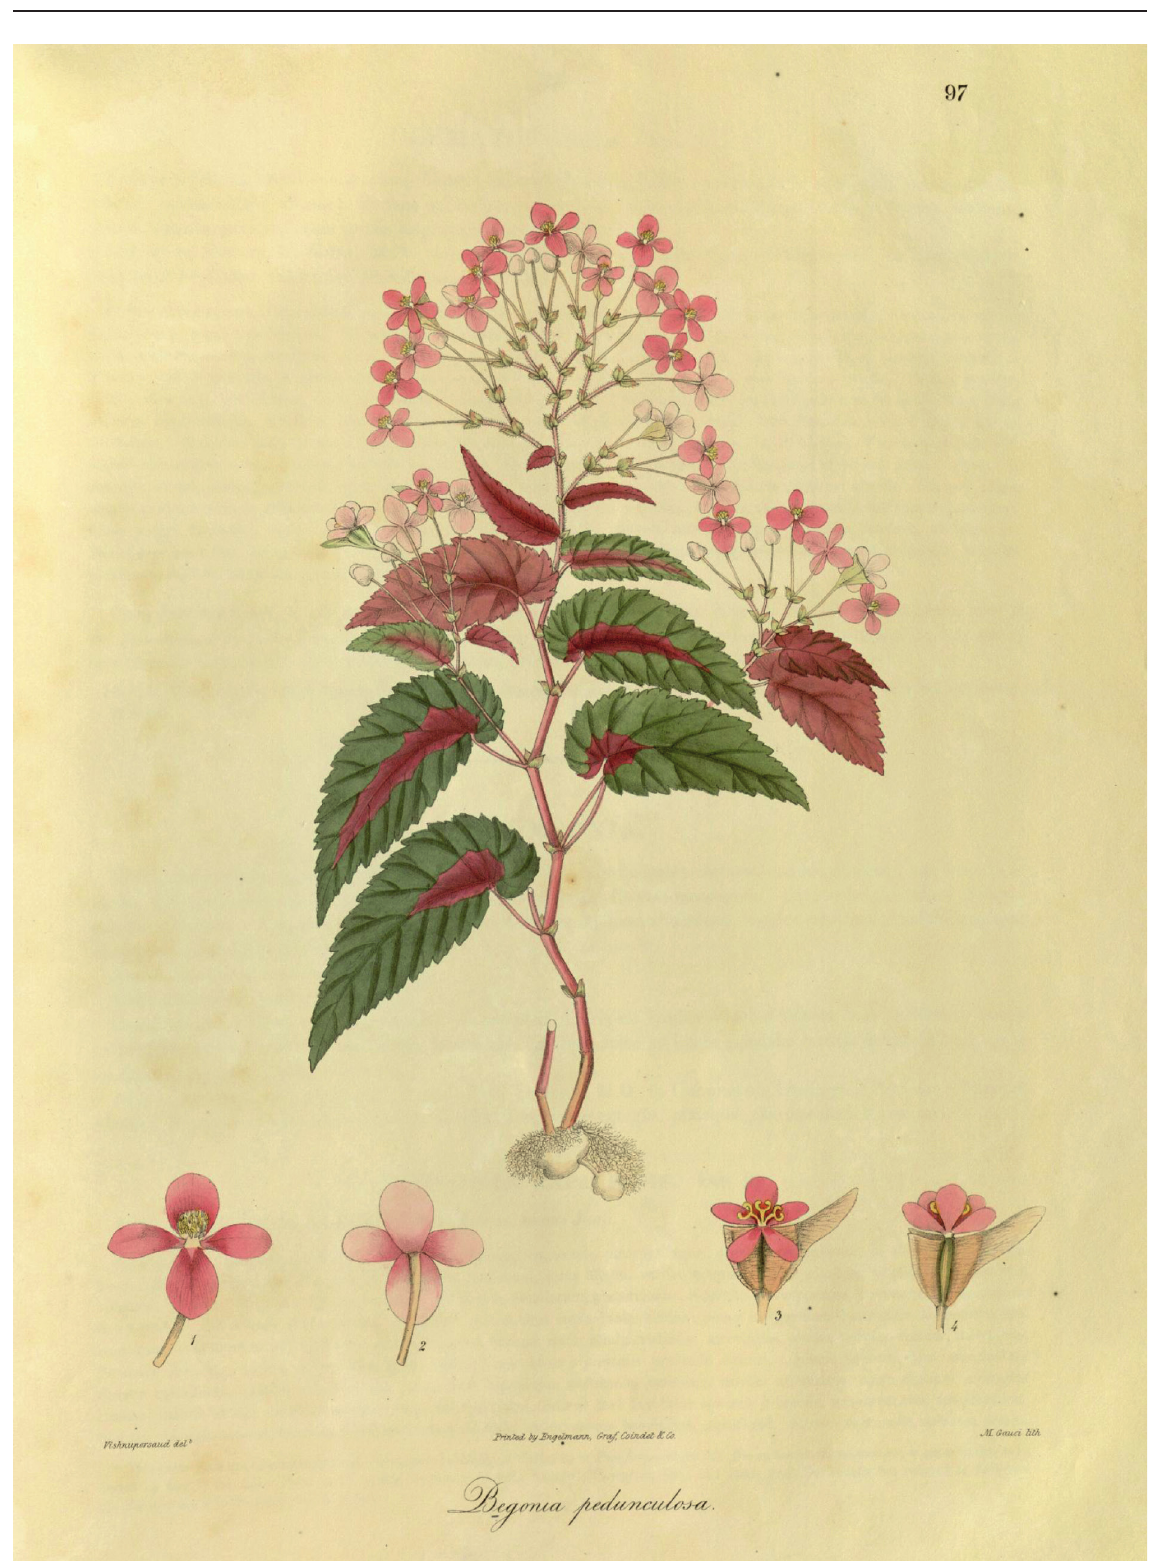
Fig. 47. Illustration of B. pedunculosa Wall. by Vishnupersaud (Wallich 1830). 1. Male flower, front view. 2. Male flower, reverse view. 3. Female flower, front view. 4. Female flower, reverse view. Image from the Biodiversity Heritage Library, digitized by the Peter H. Raven